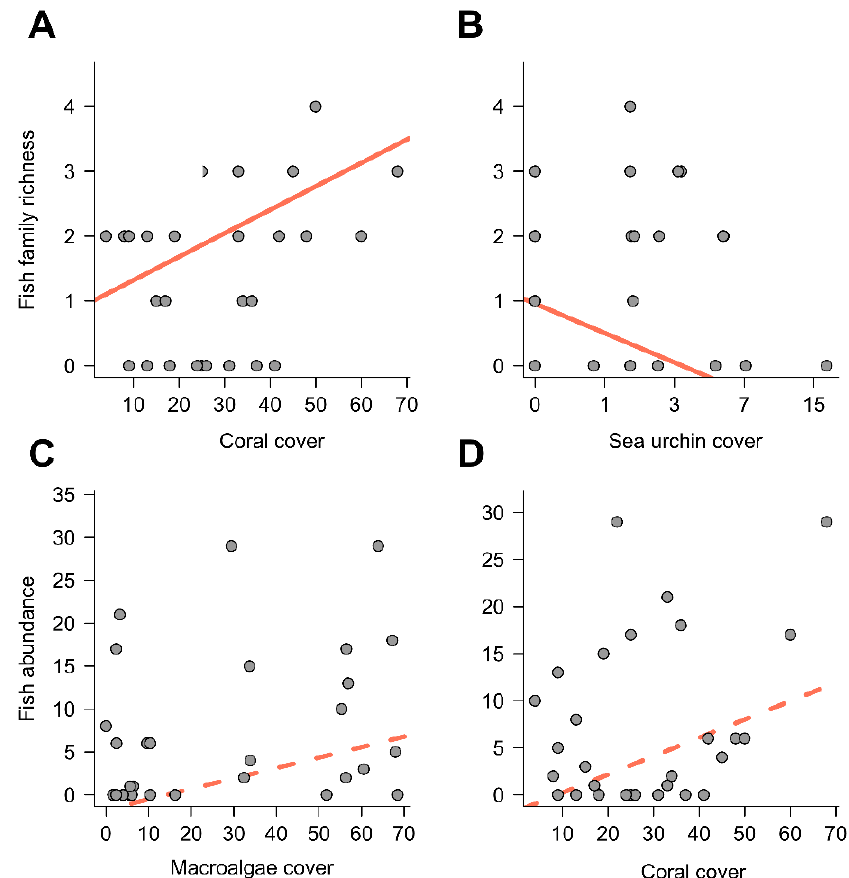
Figure 3. Relationship of different environmental factors to fish family richness and fish abundance. The orange lines represent the estimates derived from multiple-regression analysis. Fish family richness increases with increasing coral cover ( A ) and decreases with increasing invertebrate/sea urchin abundance ( B ). Fish abundance increases with increasing coral cover ( C ) and macroalgae cover ( D ). Grey dots show individual measures of response variables on the 30 transects.